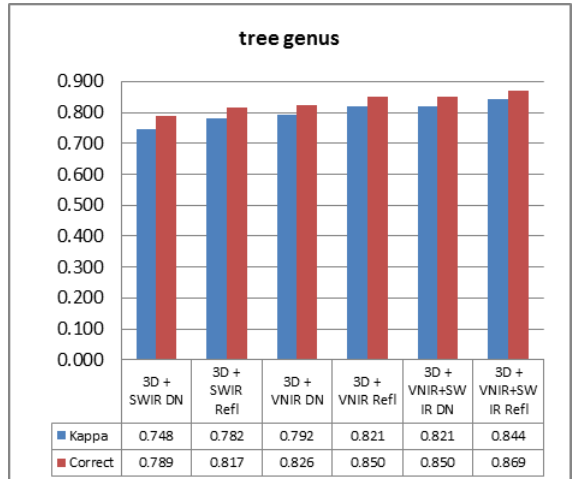
Figure 3. Results of tree genus classification (kappa + proportion of correct